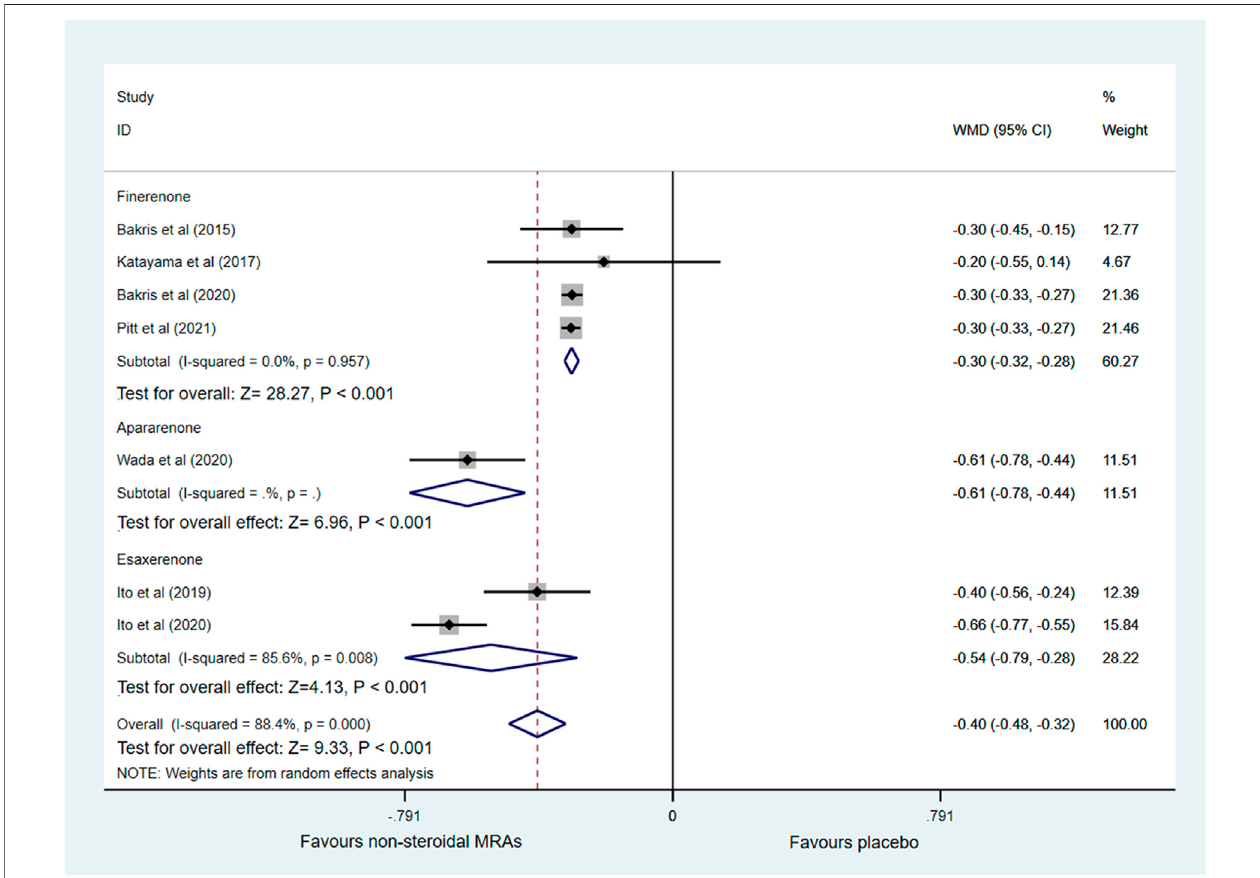
FIGURE 3 | Forest plot for the effect of non-steroidal MRAs on the changes in UACR from baseline in patients with CKD and T2D. UACR, urinary albumin-to- creatinine ratio (expressed in altered ratio); WMD, weighted mean difference; MRAs, mineralocorticoid receptor antagonists; CKD, chronic kidney disease; T2D, type 2